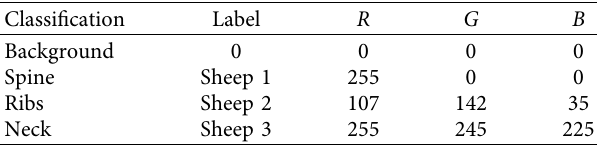
Table 1: Marked color of three parts in sheep carcass.